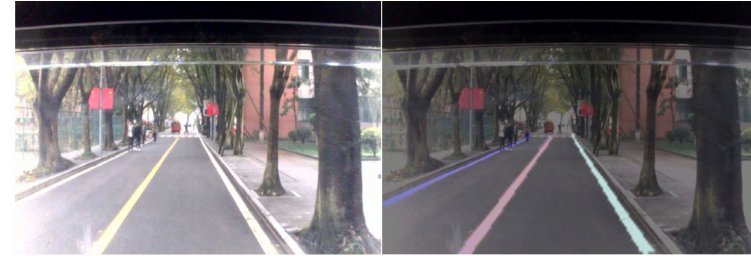
Figure 5. Effect of